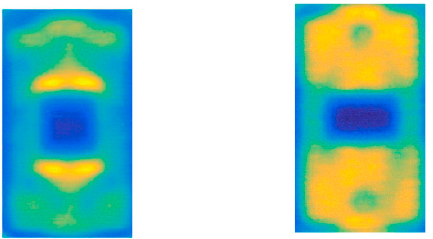
Figure 18. Transmission images of an authentic (right) Intel chip and a counterfeit one (left). Reprinted with permission from [118] © Elsevier.